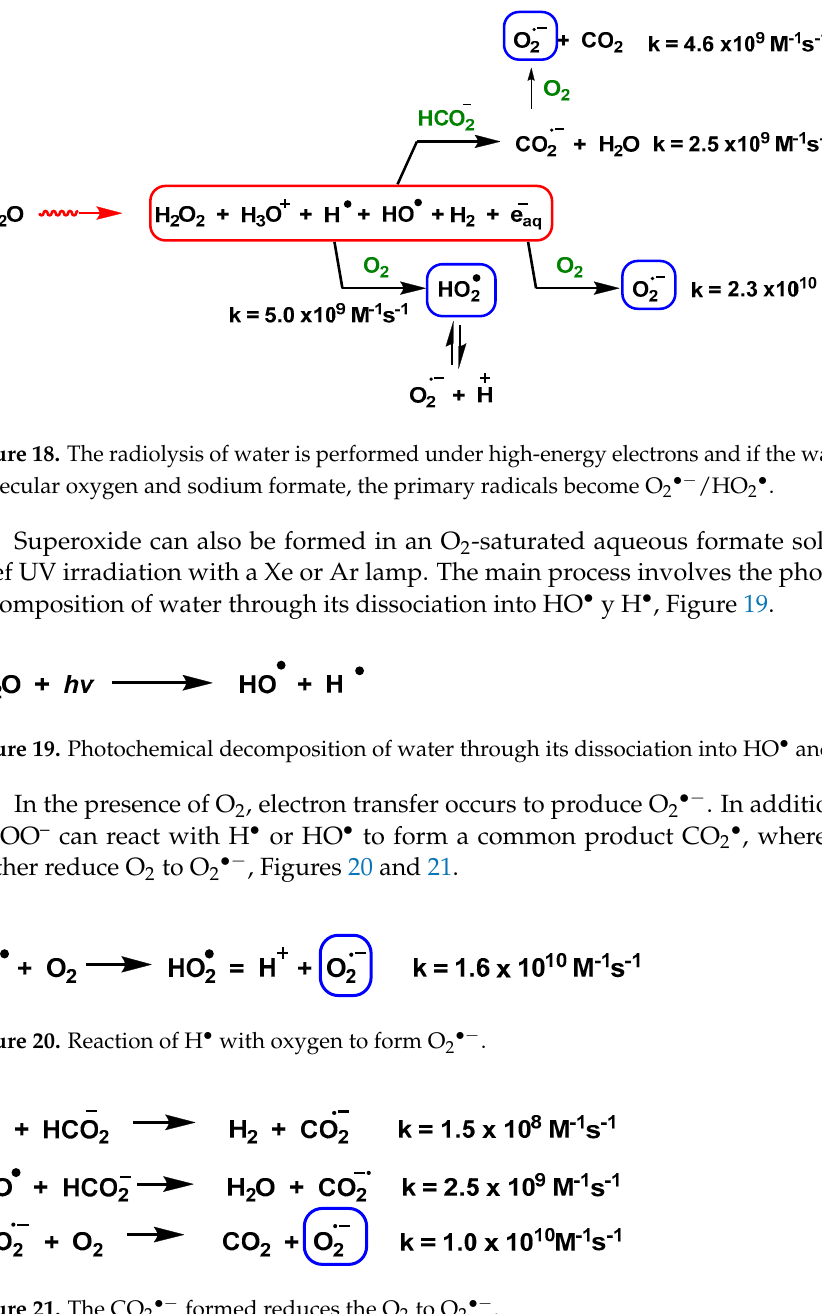
Figure 22. UV photolysis of H 2 O 2 forms HO 2• .